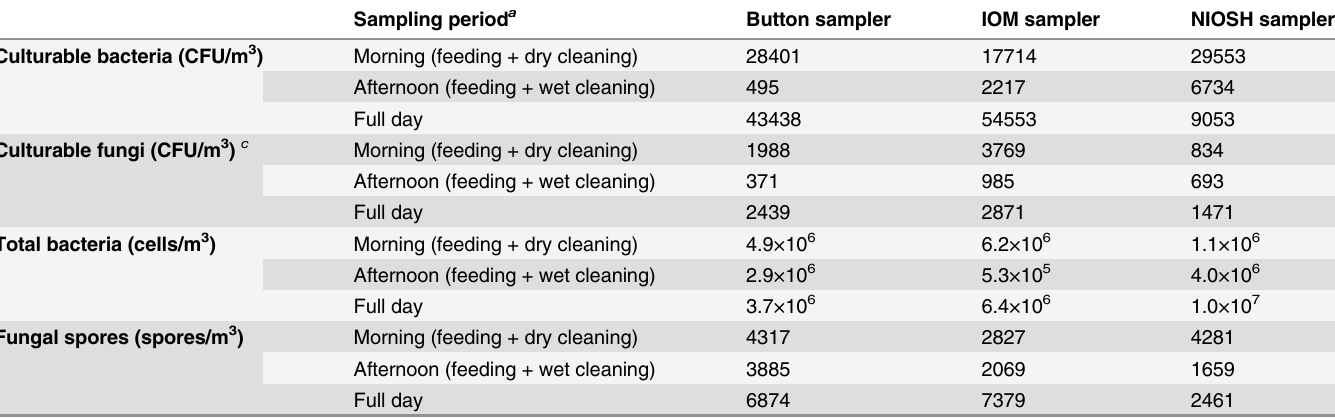
Table 7. Concentrations of personal bioaerosol exposure in a pig